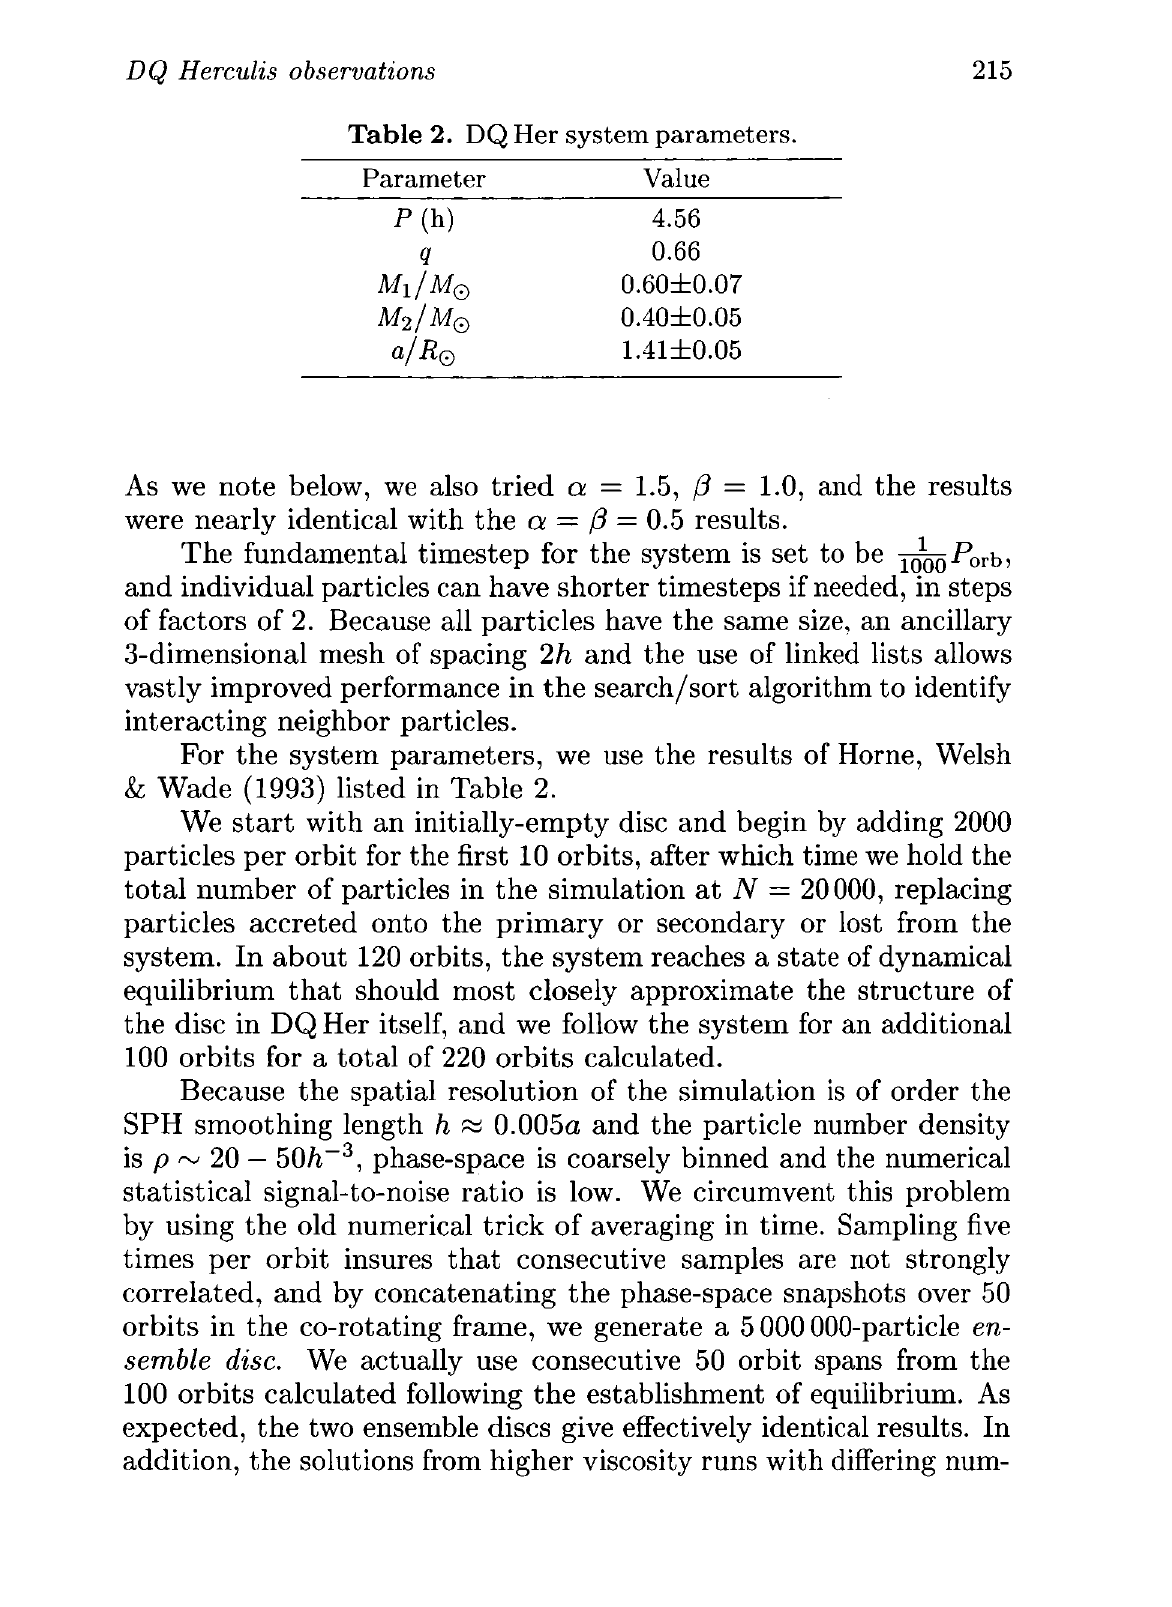
Table 2. DQ Her system